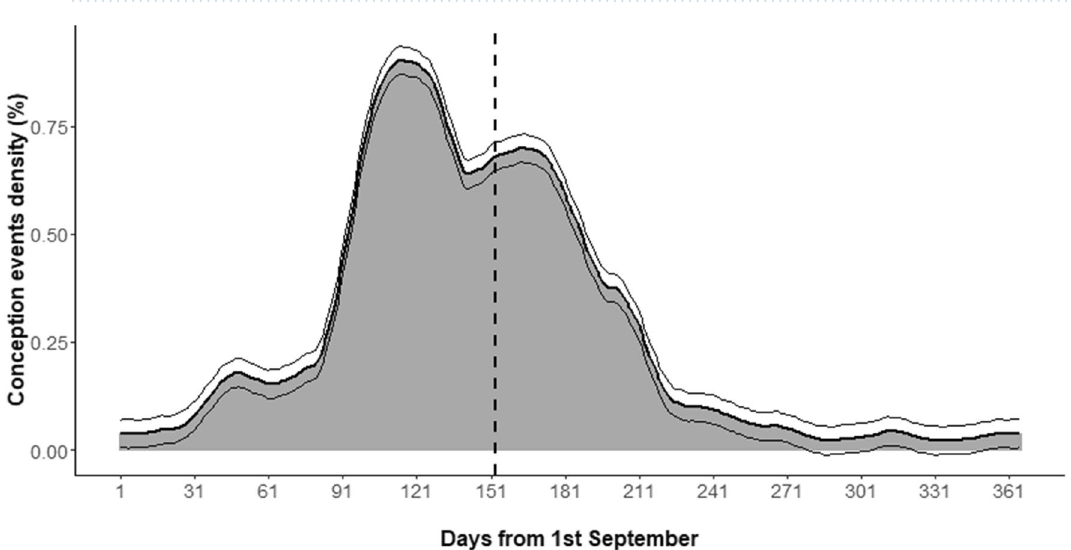
Figure 2. Conception event smoothed distribution throughout the year assessed from individual age of piglets and subadult individuals, culling date, and gestation period (see the text for more details). Upper and lower thin lines represent the distribution of mean + SE and mean − SE, respectively. Date is expressed as days from 1st September and equivalent to the sampling day. The dashed line represents the end of the sampling period (153 days, from 1st September to 31st